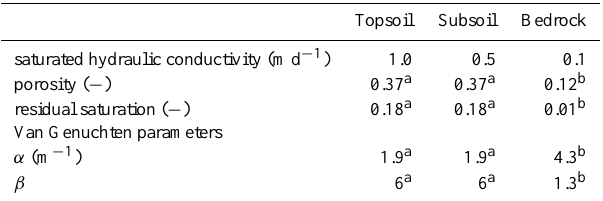
Table 1. Hydraulic properties of the subsurface